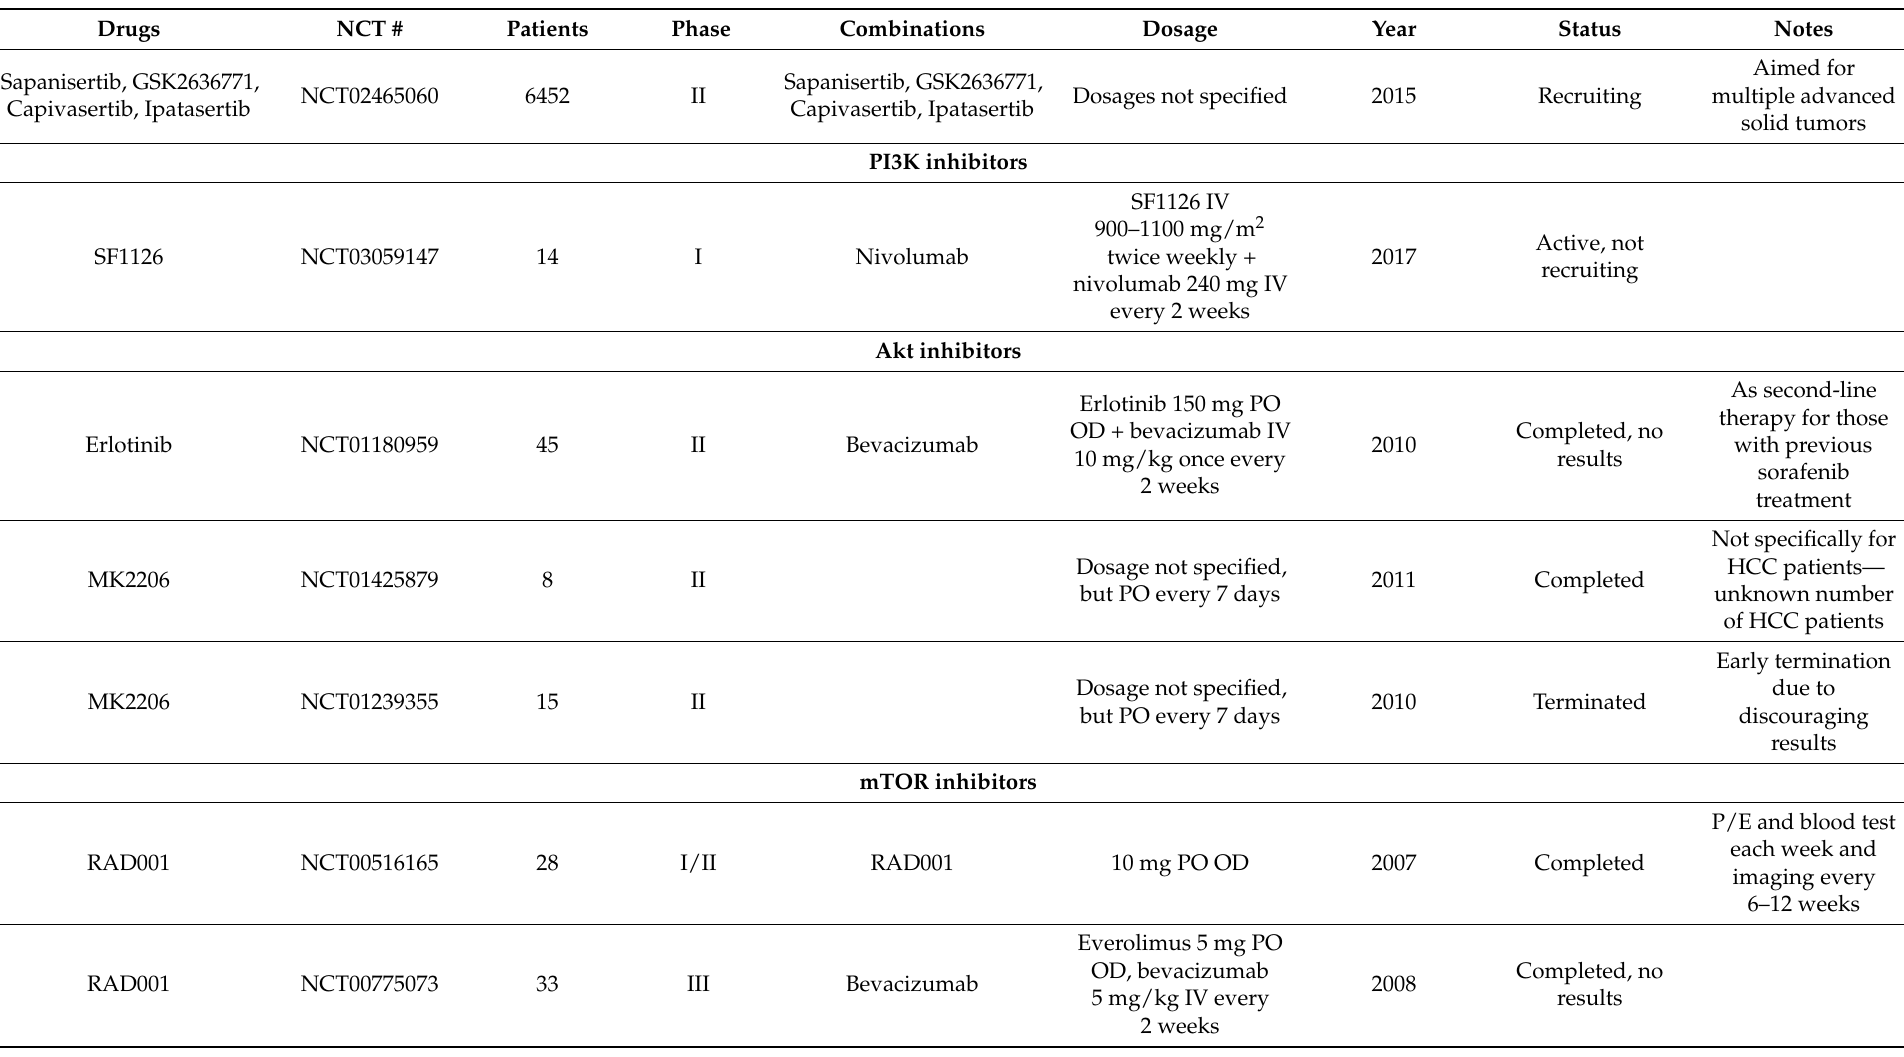
Table 2. Ongoing clinical trials with pharmaceuticals associated with PI3K/Akt/mTOR signaling pathway blockade in